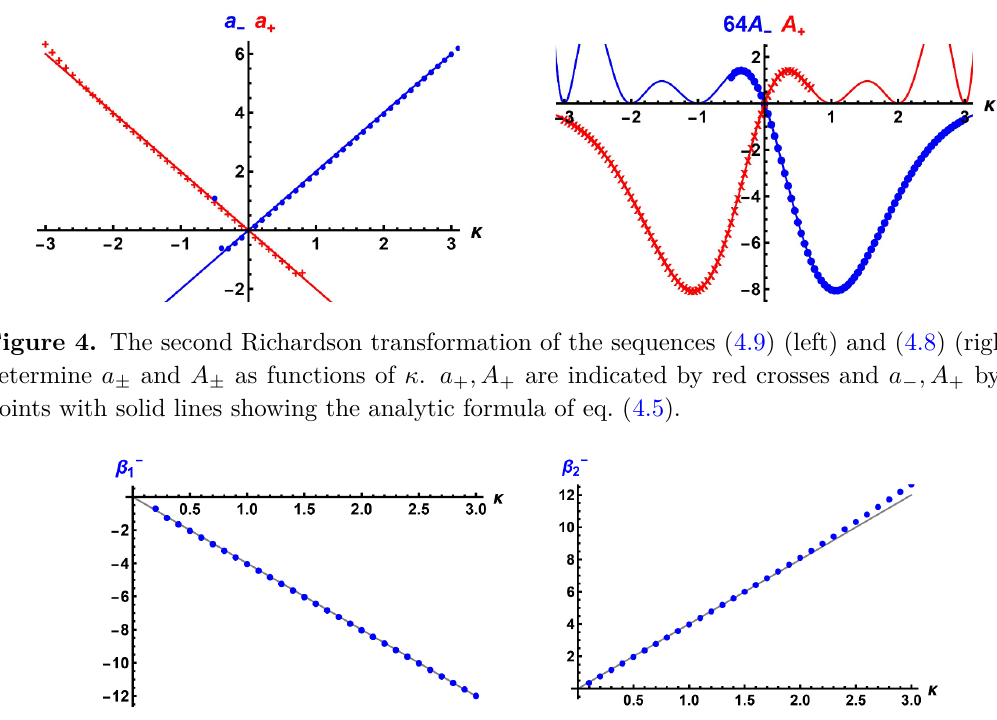
(left) and β − (right) for various values of κ . Shown is the Figure 5. The sub-leading coefficient β − 1 2 terminal value of the third Richardson Transformation of the sequence that gives β − constructed n from f after subtraction of leading alternating and non-alternating asymptotics. Grey lines cor- n respond to β − = − 4 κ and β − = +4 κ . A noticeable drift in β − for larger values of κ suggests 1 2 2 pollution from further sub-dominant terms contributing at this order of perturbation